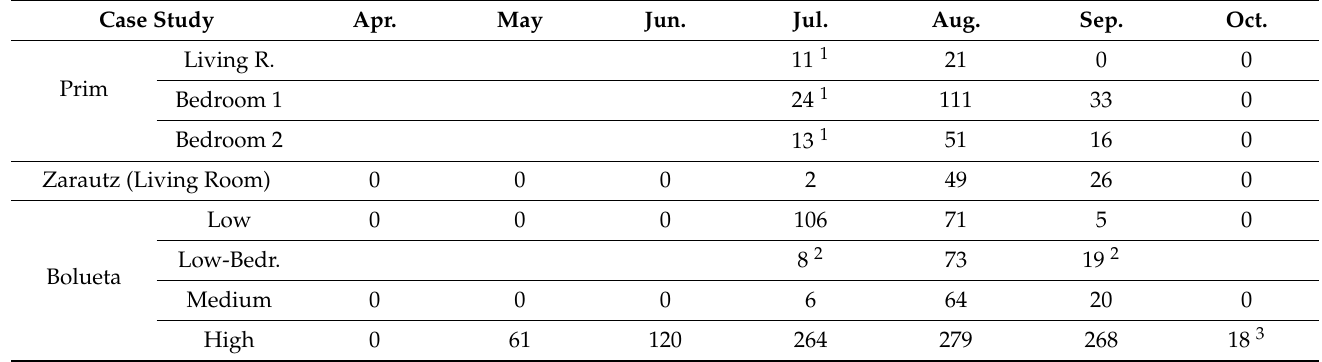
Table 11. Number of night-time hours (22:0008:00) where T > 26 ◦ C, April–October